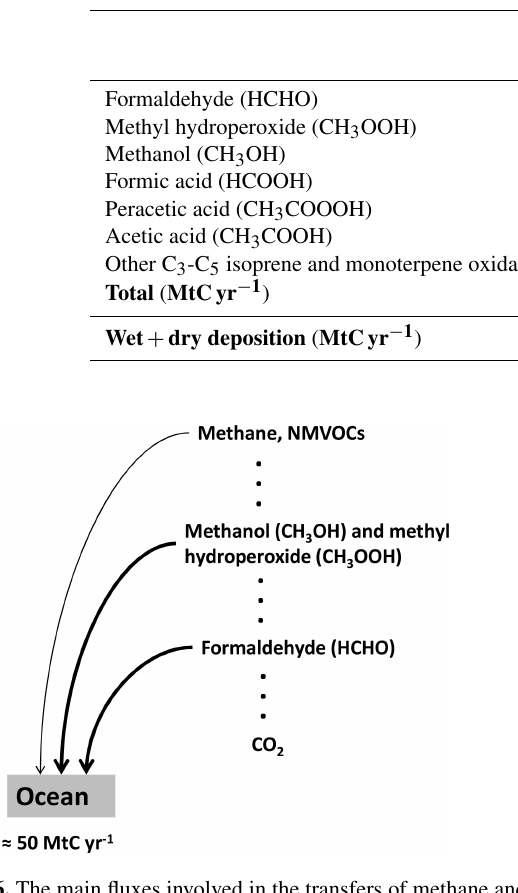
Figure 6. The main fluxes involved in the transfers of methane and NMVOCs to the oceans. Details of the estimated fluxes are given in Table